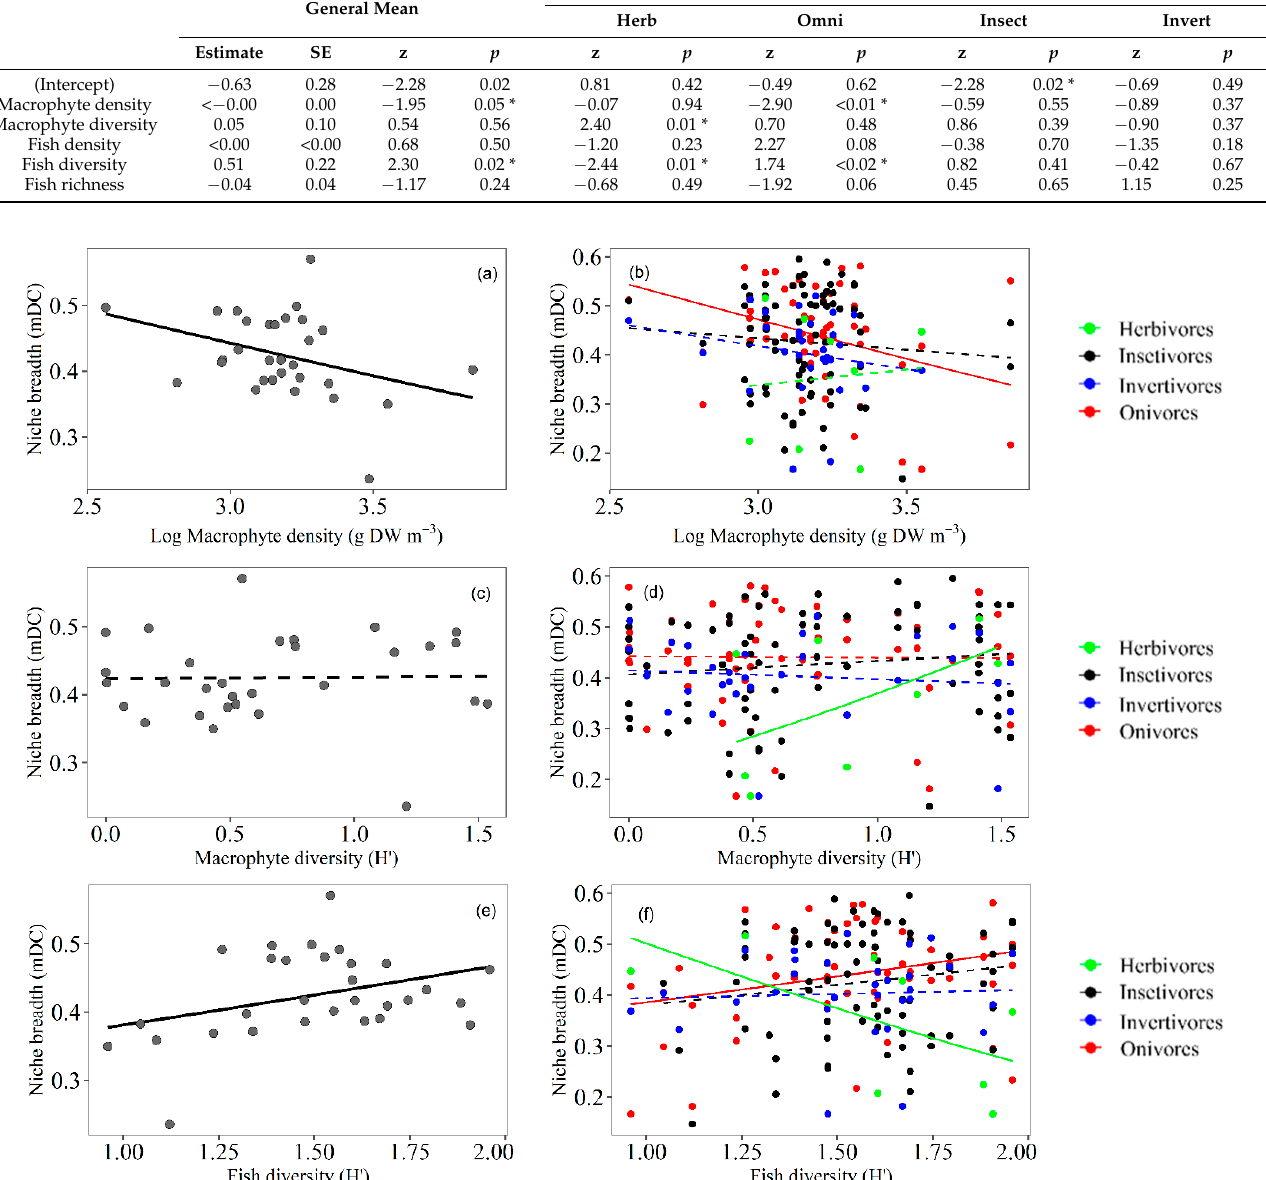
Figure 4. Trophic niche breadth, assessed by the mean of the distance from the centroid (mDC) considering a general mean ( a , c , e —gray dots) and a mean calculated for each trophic guild separately ( b , d , f —colorful dots), related to the variables with a significant effect for some of the trophic guilds or for the general mean in the performed beta regression. Dashed lines represent non-significant models. Note that log scale was used for macrophyte density.